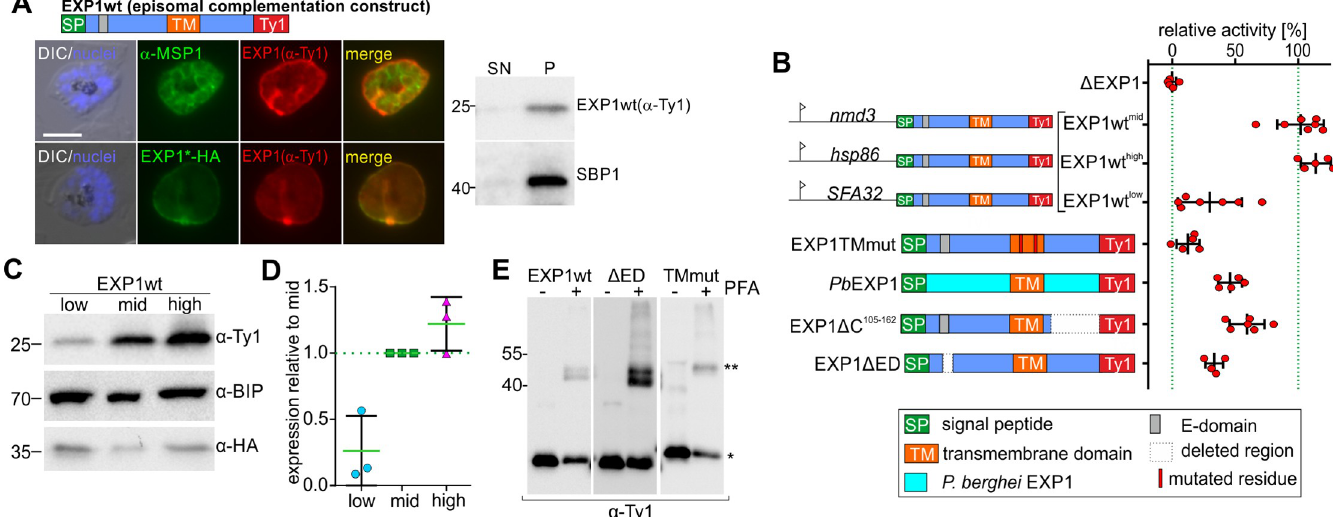
Fig 3. Complementation pinpoints important regions of EXP1. (A) IFA images of cond Δ EXP1 schizont stages expressing EXP1 wt-Ty probed with α -HA and α -Ty show localization of EXP1 � -HA and EXP1 wt-Ty in the PVM. α -MSP1 (MSP1) labels the PPM. DAPI, nuclei; scale bars, 5 μ m. Right: immunoblot of extracts of cell line on the left probed with α -Ty to detect EXP1wt-Ty and α -SBP1 as control for a TM protein. Saponin was used to separate the parasite pellet (“P”) from the supernatant (“SN”) containing PV and host cell content. See S3 Fig for IFAs and immunoblots of all complementation constructs. (B) Relative activity of the EXP1 complementation constructs indicated. Except where otherwise indicated, constructs were expressed under the nmd3 (mid) promoter. The complementation capacity of every tested construct was calculated as relative activity to the EXP1wt-Ty construct under the nmd3 promoter, which was set as 100% (right dotted green line). Δ EXP1 was set to 0% (left dotted green line). Each data point (red dot) shows growth of rapalog-treated versus unexcised parasites at the end of a 5-day growth assay relative to the growth of the wt construct; n � 4 independent experiments per cell line. Error bars: SD. See S2 Fig for activity of all complementation constructs. (C) Immunoblot of lysates of cond Δ EXP1 parasites expressing EXP1wt low , EXP1 mid , and EXP1 high probed with α -Ty (EXP1wt-Ty), α -HA (EXP1 � -HA), and α -BIP (loading control). (D) Densitometric analysis of EXP1wt expression levels (C) under low, mid, and high promoters relative to the mid promoter (green). Mean of 3 independent experiments. Error bars: SD. (E) Immunoblot of extracts of +/ − formaldehyde (PFA) treated cell lines expressing the indicated constructs probed with α -Ty. Single asterisk: monomer; double asterisk: dimer. BIP, binding immunoglobulin protein; DIC, differential interference contrast; EXP1, exported protein 1; HA, triple hemagglutinin tag; IFA, immunofluorescence assay; MSP1, merozoite surface protein 1; PPM, parasite plasma membrane; PV, parasitophorous vacuole; PVM, parasitophorous vacuolar membrane; SBP1, skeleton binding protein 1; TM, transmembrane; wt, wild type.